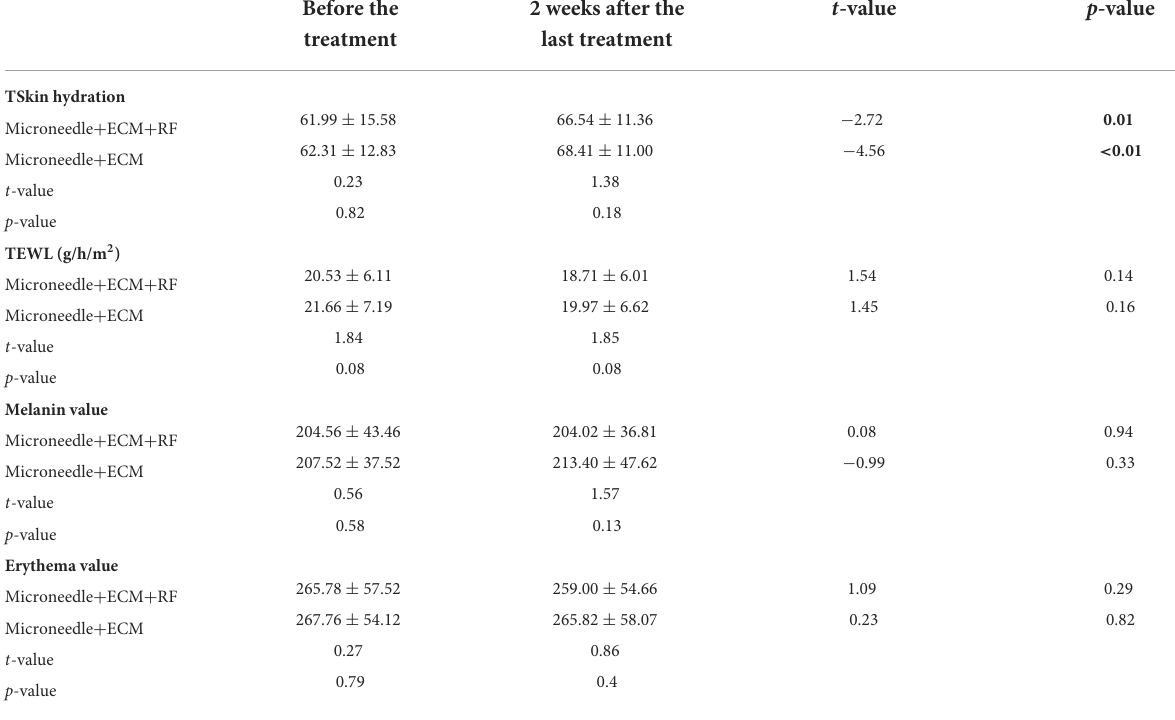
t -value p- value